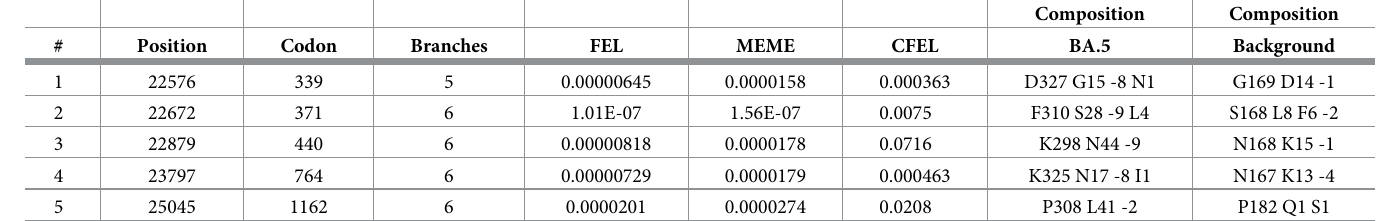
Table 3. Site profiles for selected sites in the BA.5 Spike